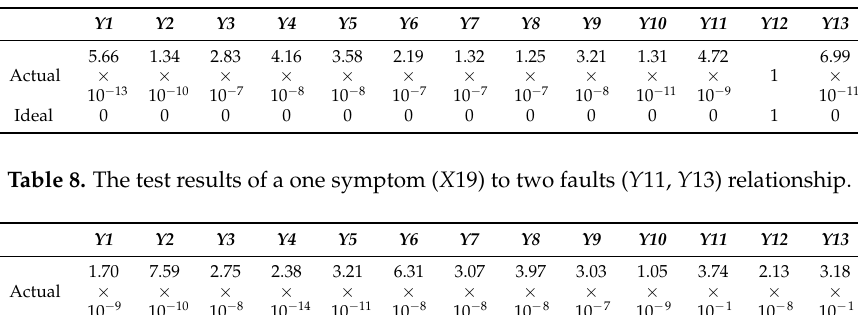
Table 7. The test results of a one symptom ( X 20) to one fault ( Y 12) relationship.